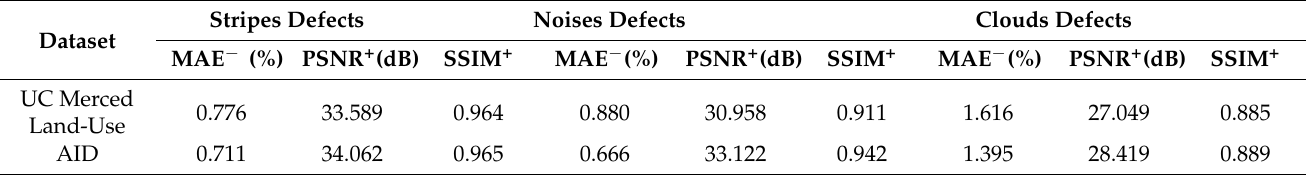
Table 6. Quantitative Inpainting Results of UC Merced Land-use Dataset and AID Dataset.